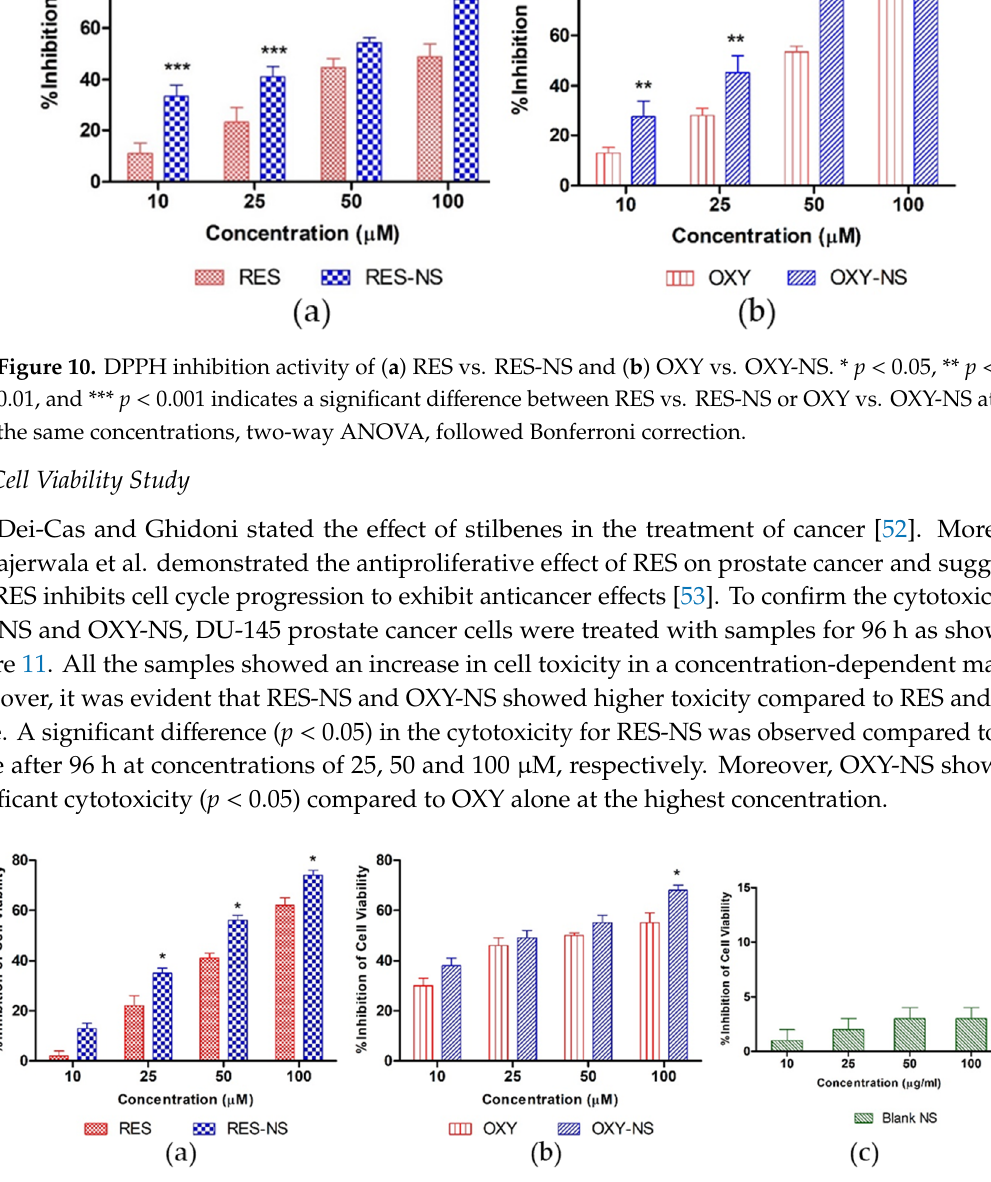
Figure 11. Cell cytotoxicity study of ( a ) RES vs RES-NS ( b ) OXY vs OXY-NS, and ( c ) blank NSs after 96 h. * p < 0.05 indicates a significant difference between RES vs RES-NS or OXY vs OXY-NS at the same concentrations.